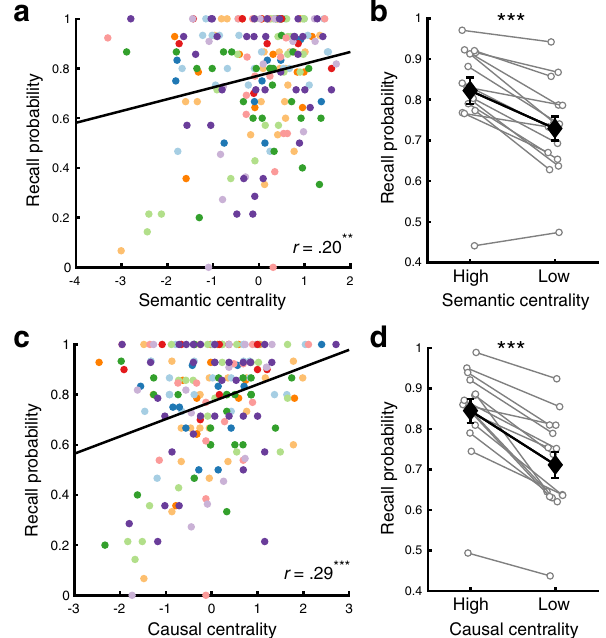
Fig. 3 Effects of narrative centrality on recall performance. a Correlation between semantic centrality and recall probability. b Recall probability for High (top 40%) vs. Low (bottom 40%) semantic centrality events de fi ned within each movie (averaged across movies). c . Correlation between causal centrality and recall probability. d . Recall probability for High (top 40%) vs. Low (bottom 40%) causal centrality events de fi ned within each movie (averaged across movies). In a and c , each dot represents an individual movie event. Different colors denote different movies. In b and d , white circles represent individual participants ( N = 15). Black diamonds represent the mean across participants within each condition. Error bars show SEM across participants. Two-tailed paired t-tests indicated that both higher semantic ( p = .00003) and causal centrality ( p = .000001) were associated with higher recall probability. ** p < .01, *** p < .001. Source data are provided as a Source Data fi